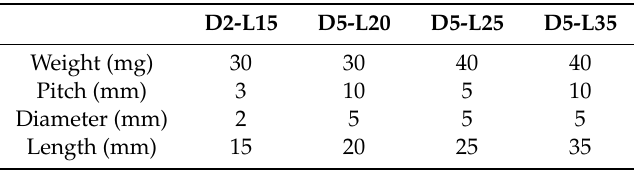
Table 1. Weight and dimension information of helical soft